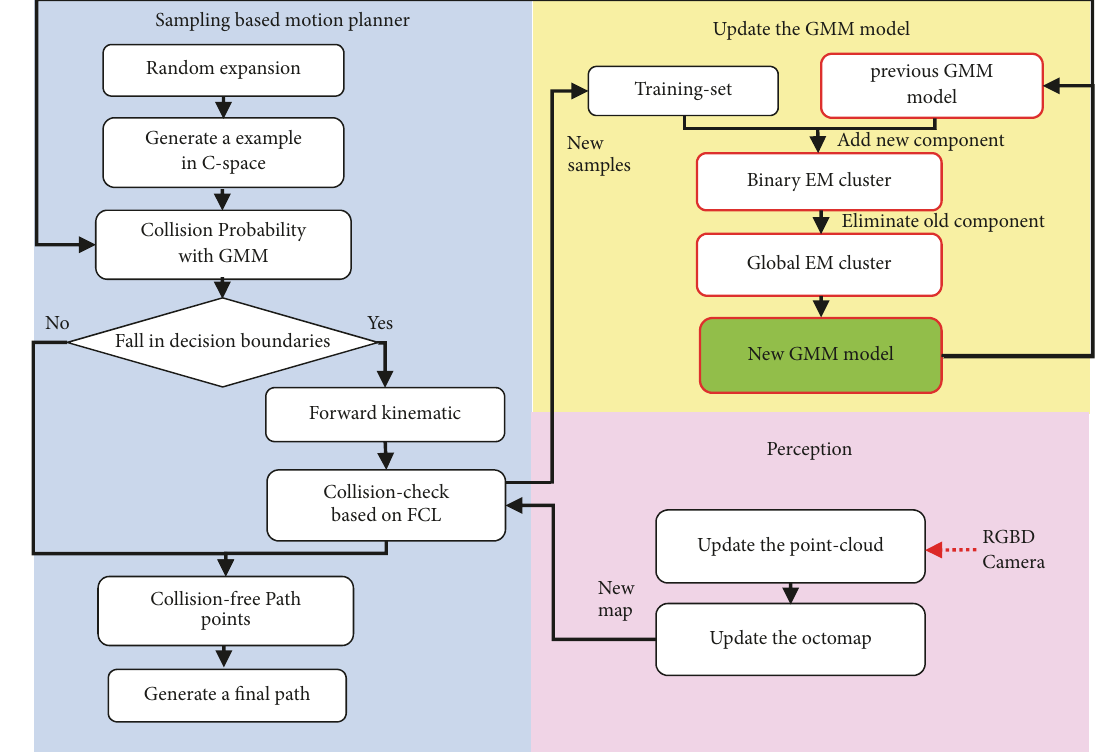
Figure 3: Algorithm framework: the main contributions are highlighted in